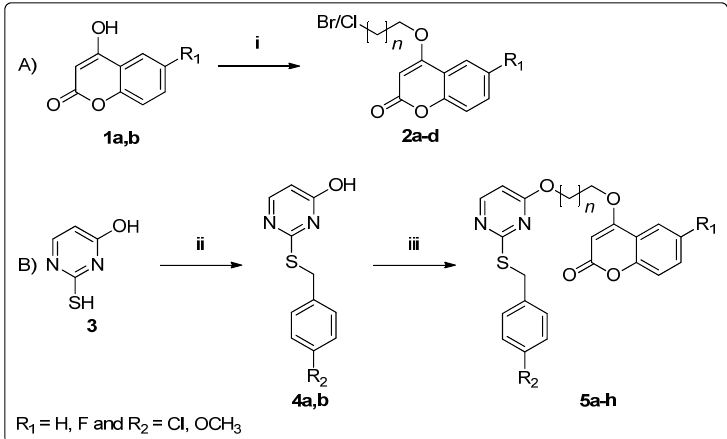
Scheme 1. Schematic representation of the synthesis of title compounds ( 5a – h ). A,